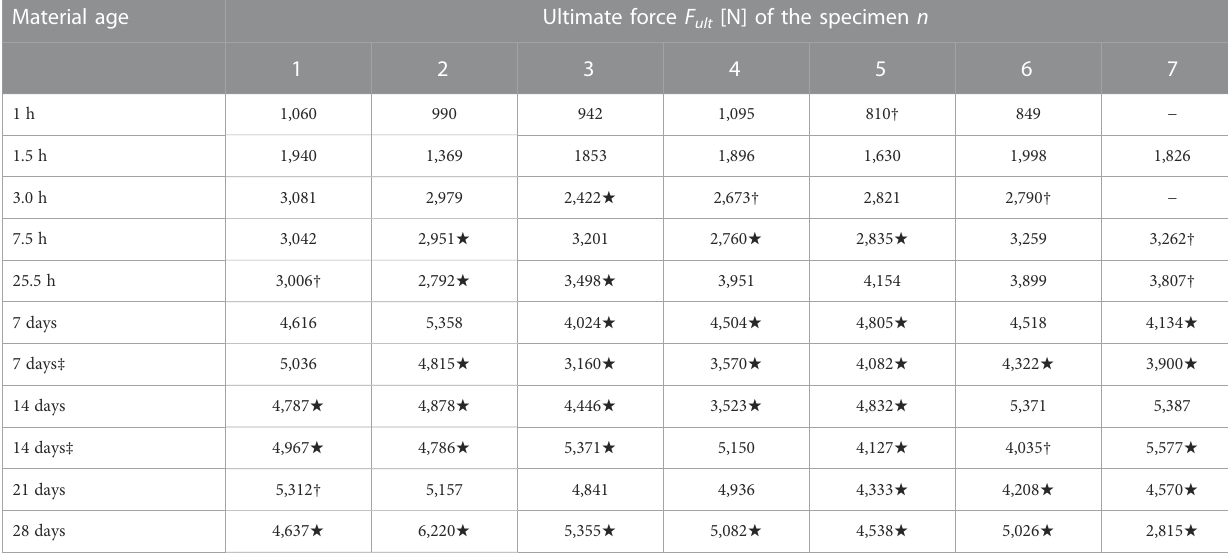
TABLE 2 Values of the ultimate compressive forces sustained by the 5/10 specimens, tested at speci fi c material ages. Material